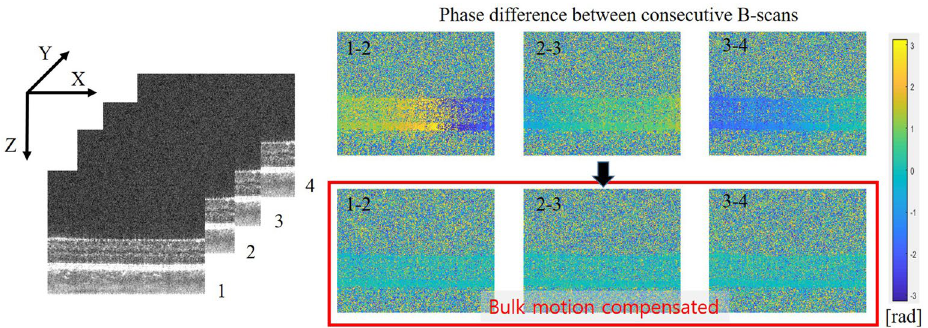
Figure 2. Phase difference between consecutive B-scans (top) before and (bottom) after compensation for bulk motion of the subject. Numbers 1, 2, 3, and 4 indicate consequently acquired